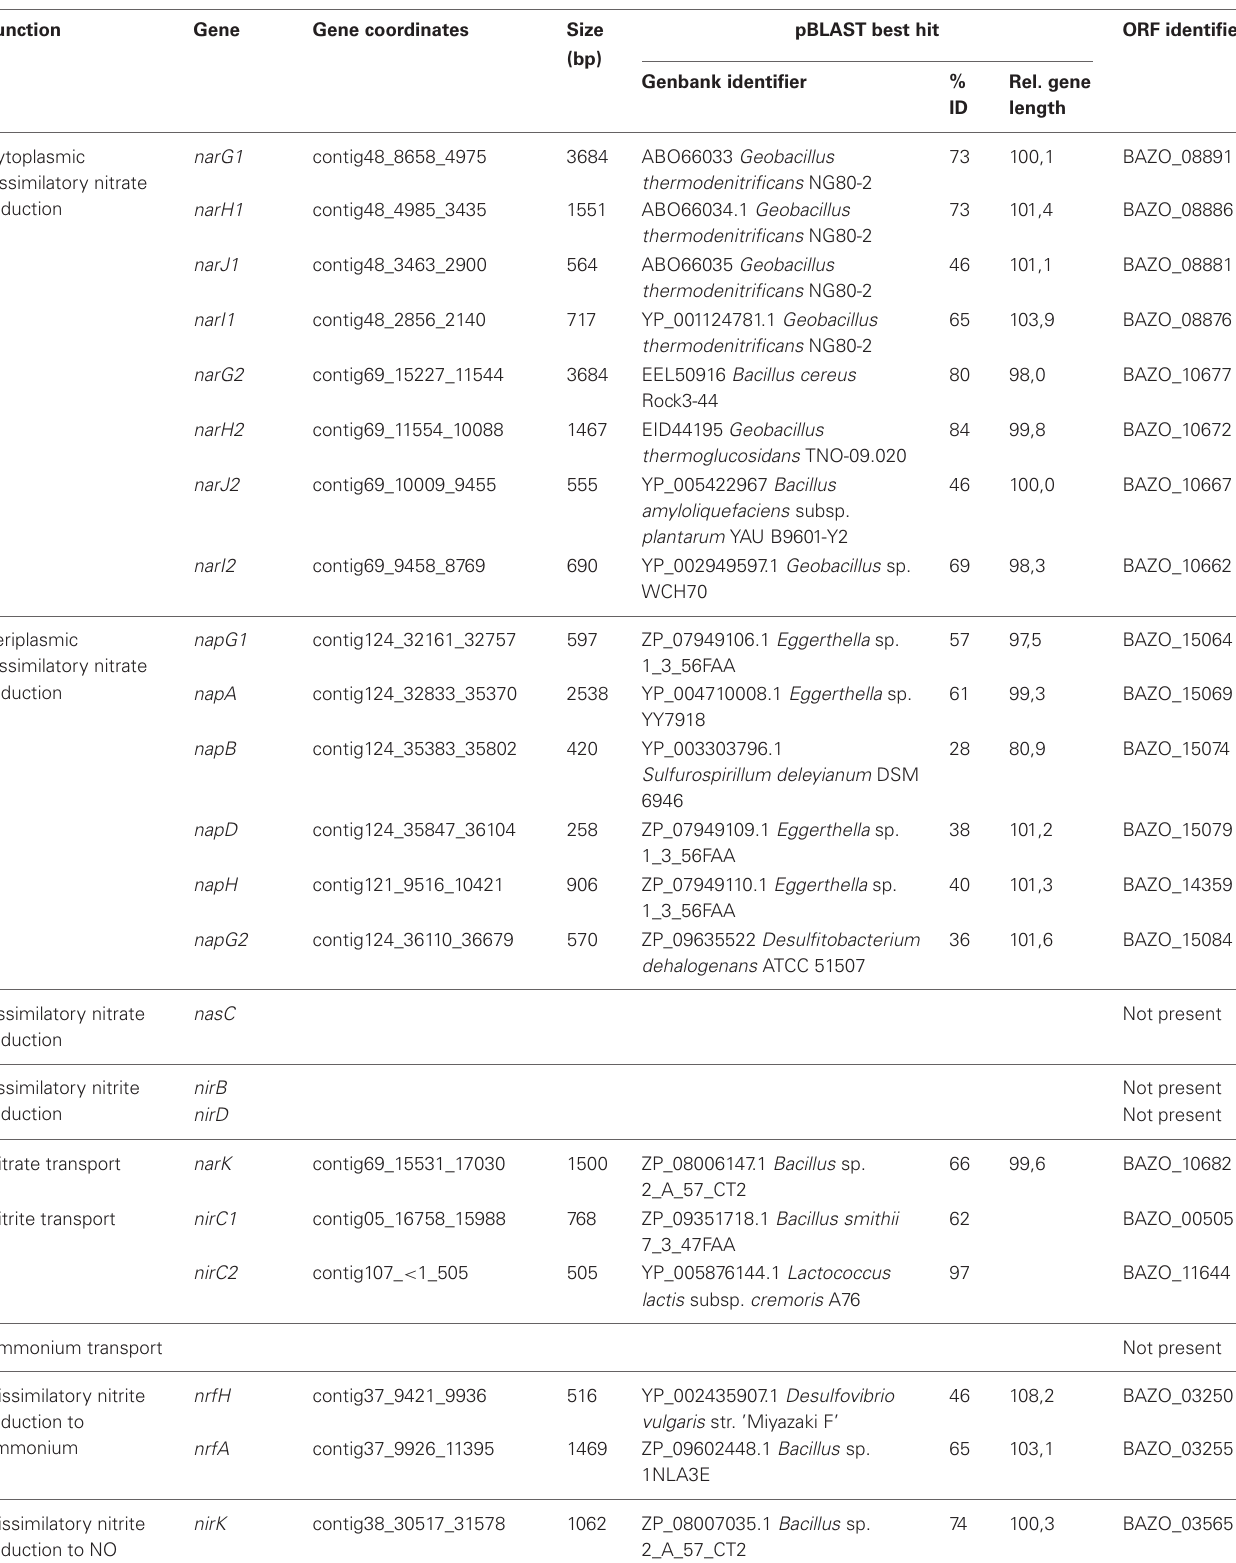
Table 2 | Overview of gene inventory involved in nitrogen assimilation, denitrification and ammonification of B. azotoformans LMG 9581 T .